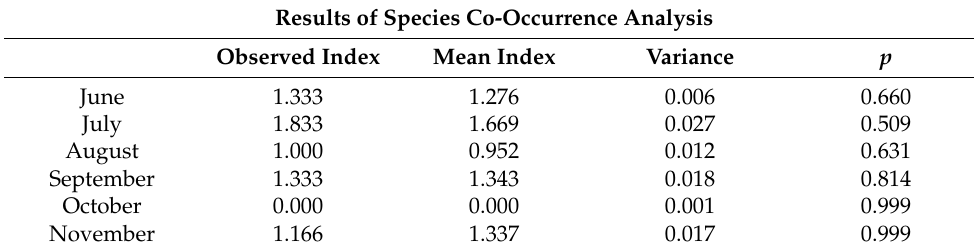
Table 4. Results of null model analysis by month sampled in the present study.